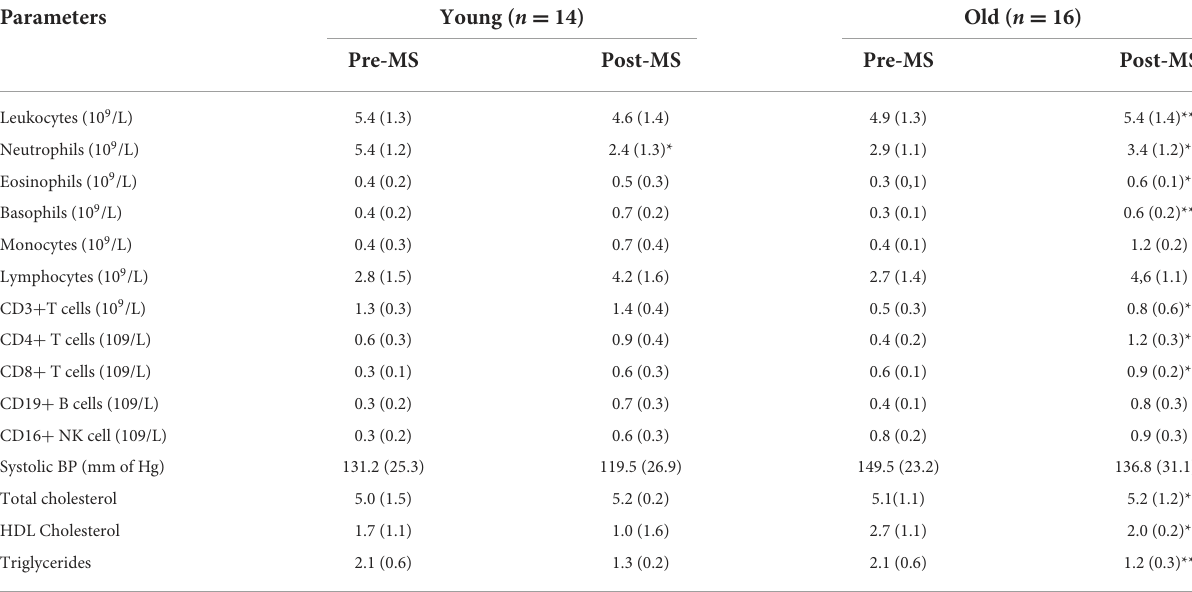
TABLE 3 Comparison of immunological and metabolic parameters between Pre-MS and Post-MS regimens in young and old individuals.